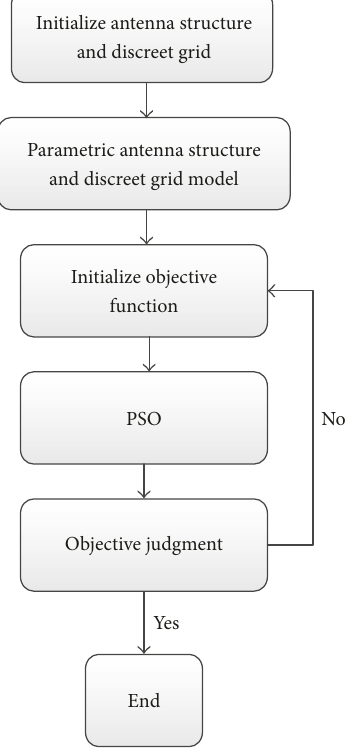
Figure 3: Antenna optimization